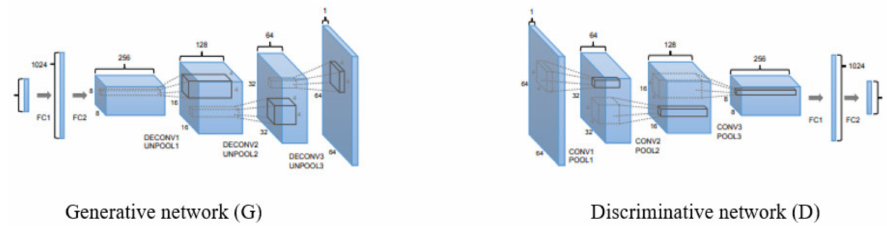
Figure 1. The generative network G ( left ) and the discriminative network D ( right )